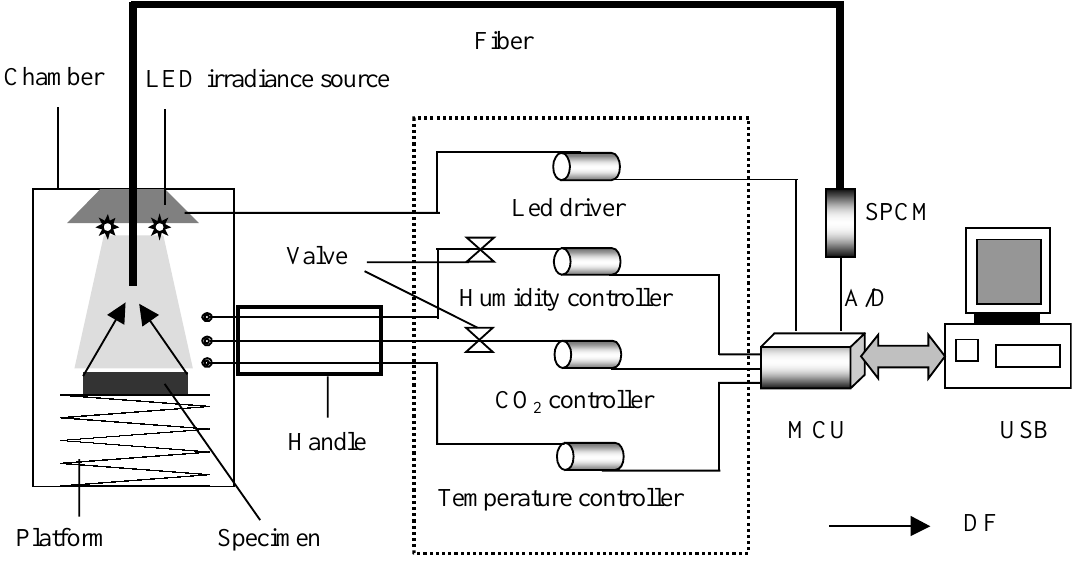
Figure 1. Diagram of experimental setup for DF measurement: LED, SPCM and MCU represent the light-emitting diode, single photon counting module, and micro control unit (AT89c55),